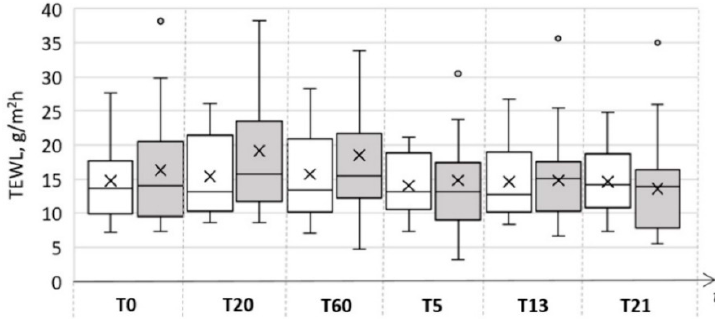
Figure 4. TEWL measurements of the control and test area in the short-term and long-term study (grey boxes are test values, white are control).